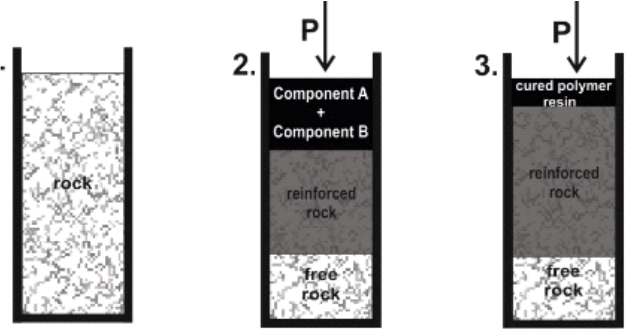
Figure 5. The sand rock reinforcement by stepwise injection of the prepared two-component silicate resin: 1 — the installation of the rock in the test chamber; 2 — the injection of the prepared resin solution (mixture of components A and B in a volume ratio of 1:1); 3 — the extrusion of the injected resin solution with compressed nitrogen deep into the rock.